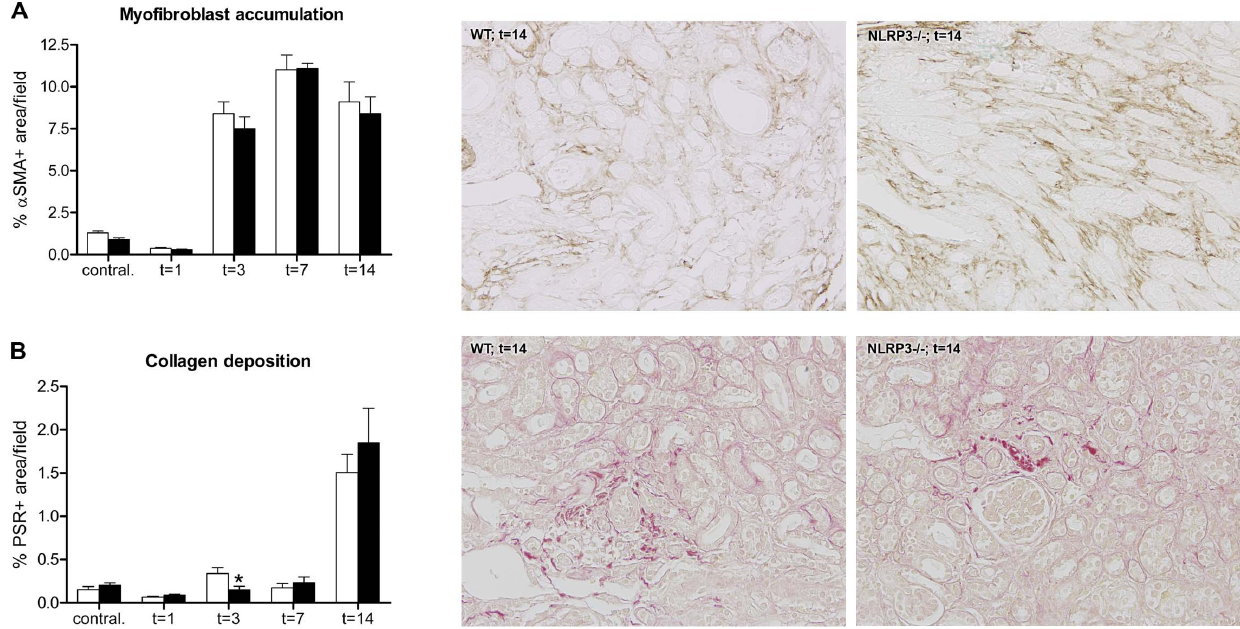
Figure 7. Nlrp3 deficiency does not affect myofibroblast accumulation and collagen deposition following UUO. Renal myofibroblast accumulation (A) and collagen deposition (B) in obstructed and contralateral kidneys of wild type (white bars) and Nlrp3 2 / 2 (black bars) mice following UUO. Nlrp3 deficiency did not affect the accumulation of myofibroblasts in kidneys following UUO (A). Except for a difference observed at 3 days post-UUO Nlrp3 deficiency did not influence renal collagen deposition following UUO (B). Data are mean 6 SEM of 7 mice per group. Contral. = contralateral kidneys of mice subjected to 14 days of UUO. *:p , 0.05. The panels show representative microphotographs of renal tissue of mice subjected to 14 days of UUO, magnification x200. Figure S1 Renal cell-specific expression of inflamma- some components. Expression of Nlrp3 (A), ASC (B) and caspase-1 (C) mRNA in wild type primary tubular epithelial cells (TECs), myofibroblasts or endothelial cells stimulated with ( + ) or without ( 2 ) 10 ng/ml TGF b for 24 hours. In addition, bone-